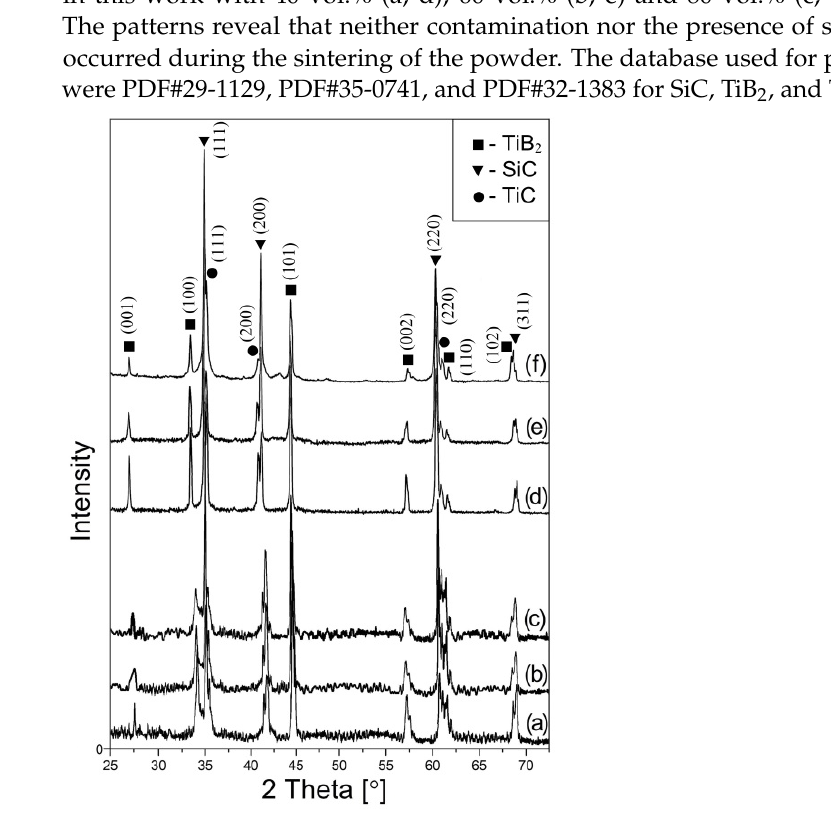
Figure 3. XRD pattern of as-prepared and sintered (at 2000 °C) SiC-TiB 2 -TiC composites with 40 vol.% (a,d), 60 vol.% (b,e) and 80 vol.% (c,f) SiC, respectively.